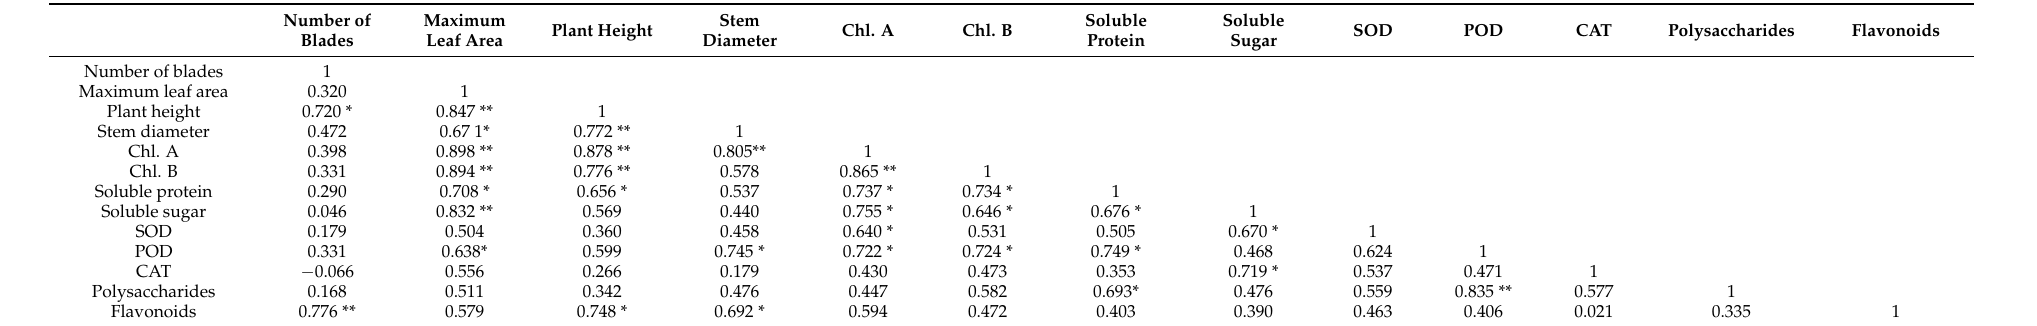
Stem Diameter Chl. A Chl. B